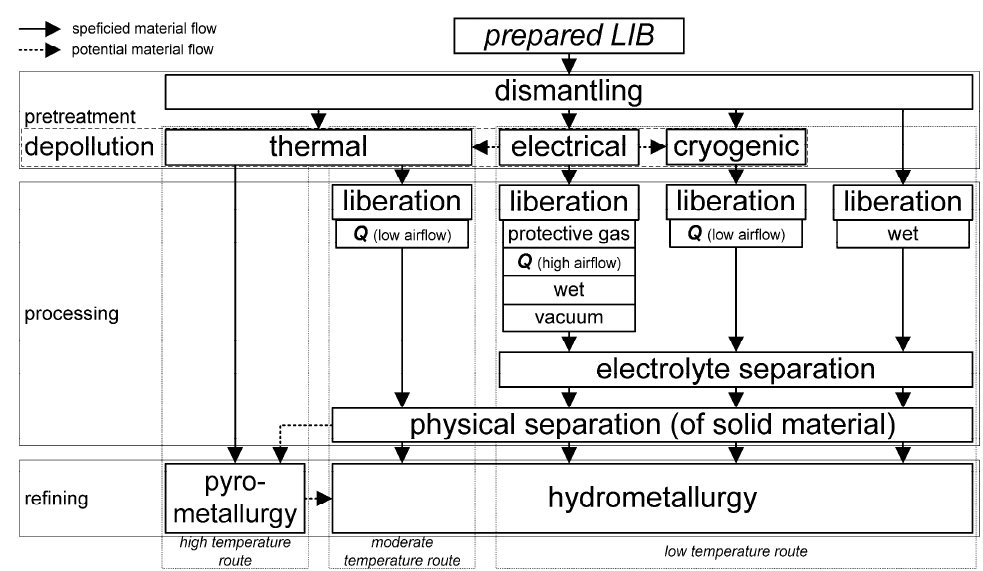
Figure 1. Depollution and liberation strategies for safe LIB cell opening with the corresponding process medium and routes.